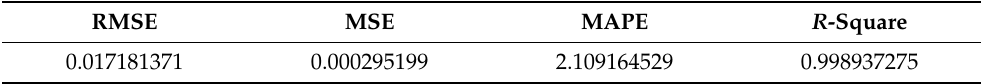
Table 8. The results of the statistical analysis of